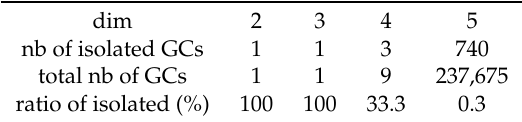
Table 2. Percentages of isolated GCs in the partition of the set of